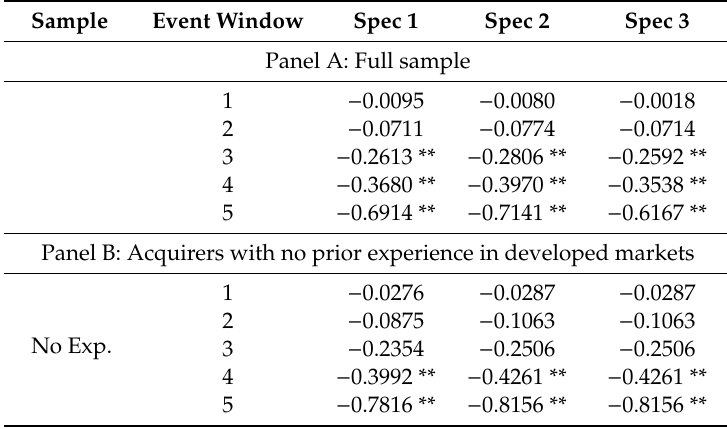
Table 4. Full sample and subsample